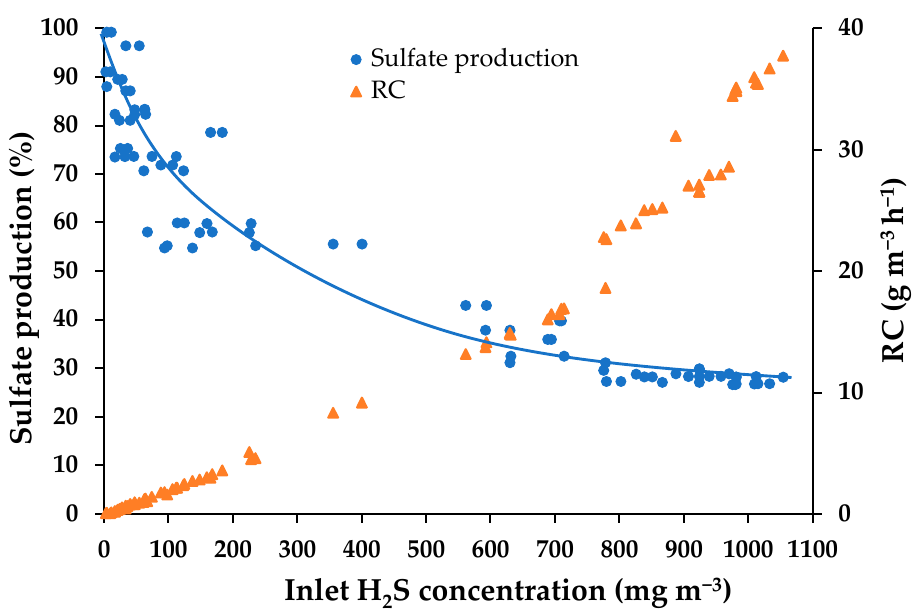
Figure 5. Loading rate (LR) and removal capacity (RC) of the biotrickling filter alone at different EBRT and H 2 S inlet concentrations.